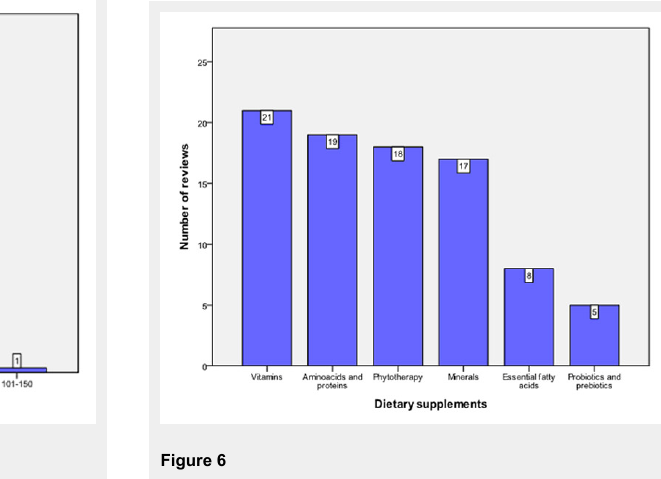
Types of dietary supplements assessed in Cochrane reviews.